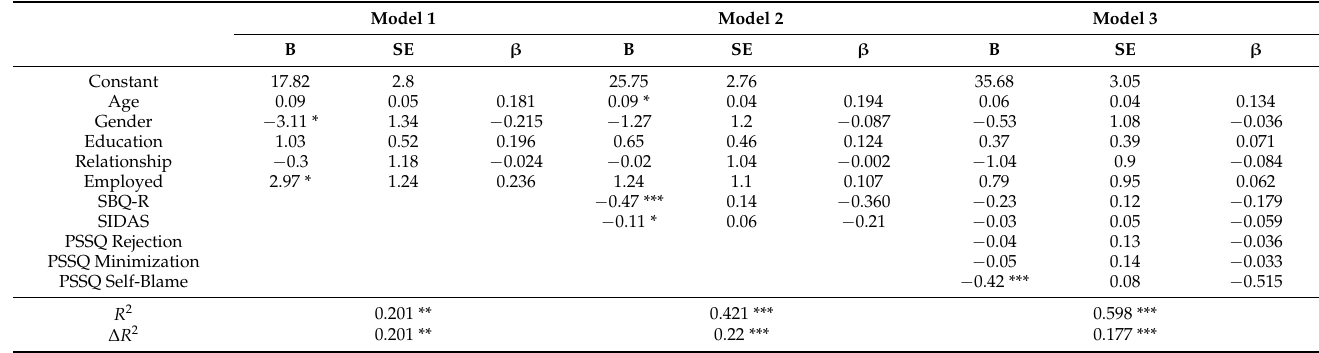
Table 2. Hierarchical regression analysis with self-esteem as the criterion (n = 100).